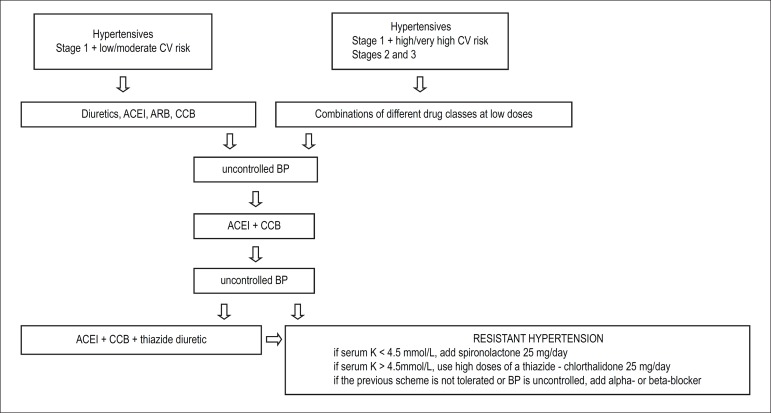
Flowchart for the treatment of arterial hypertension. (adapted from
Malachias et al1)CV: cardiovascular; BP: blood pressure; ACEI:
angiotensin-converting-enzyme inhibitor; ARB: angiotensin-receptor
blocker; CCB: calcium-channel blocker.